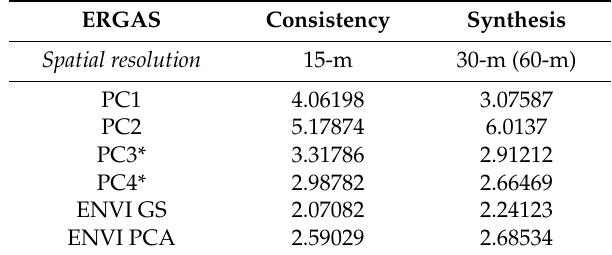
Table 5. ERGAS values for the Landsat 8 dataset. * Sharpened images for the synthesis property were created from synthetic images where PAN was degraded to the resolution of the original MUL (30-m) and the MUL was thereafter degraded to 60-m in order to keep the same spatial resolution ratio. For ERGAS, the best possible result is zero, which indicates two identical images. It was expected that the first two PCs have the potential to give good results when employing the PCA sharpening process, however PC3* and PC4* were used to compare the result and explain it in a wider